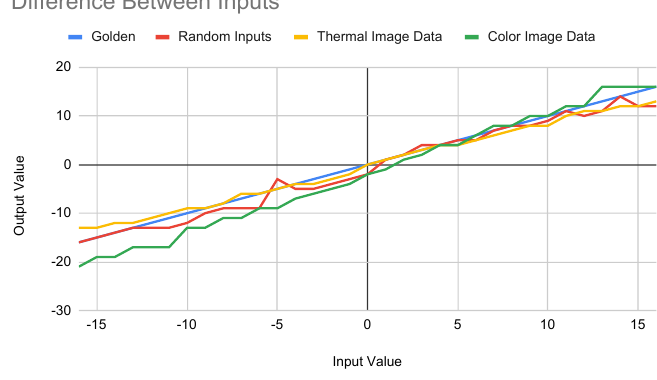
Figure 7. Mapping on Different Input Sources.